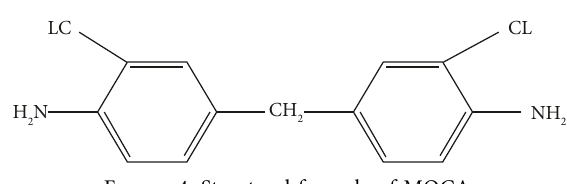
Figure 3: Structural formula of IPDI.